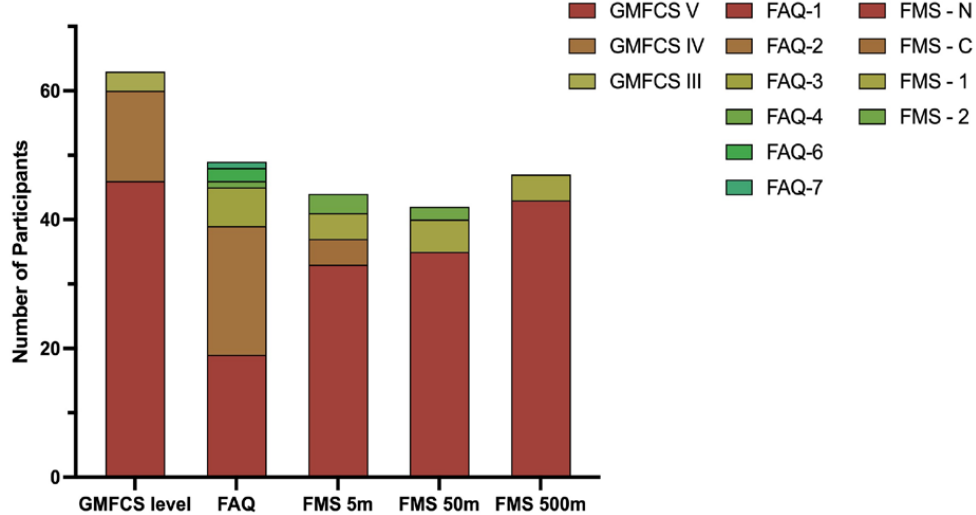
Figure 3. Functional mobility at baseline, including all reported levels for GMFCS, FAQ-10, and FMS.